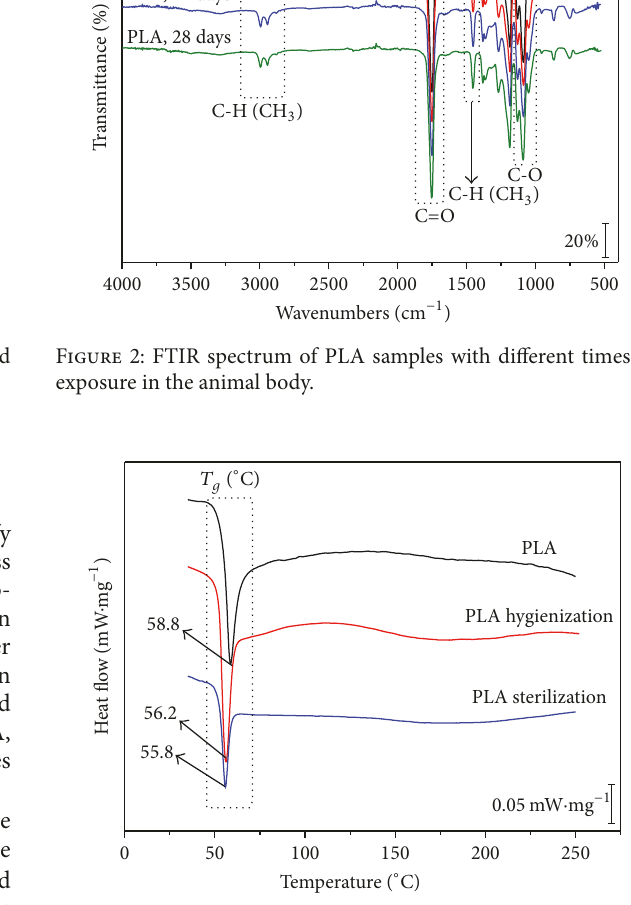
Figure 3: DSC thermograms of the PLA before and after the hygienization and sterilization